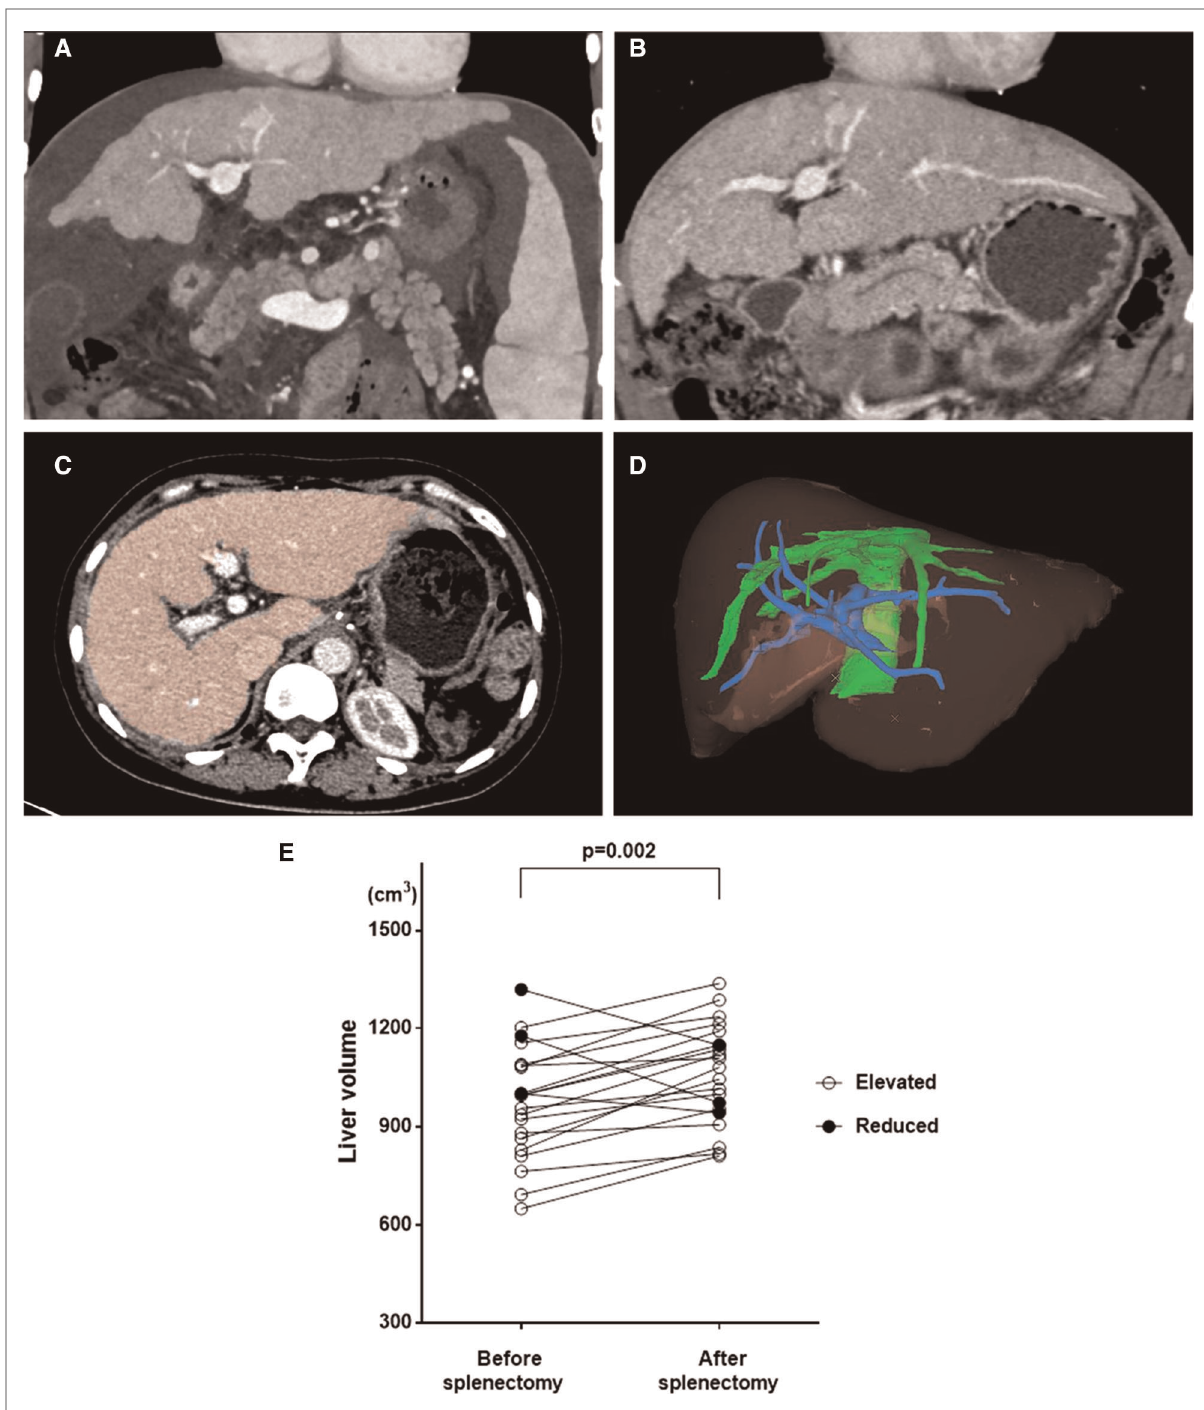
FIGURE 4 Liver regeneration were observed in many patients after surgery, we applied The Myrian® XP-Liver Work Environment (Myrian, Intrasense, France) to measure the liver volume. ( A ) CT image before surgery showed liver cirrhosis and reduced liver volume; ( B ) CT image after surgery on same layer exhibited increased liver volume which indicated liver regeneration after surgery; ( C ) The liver was stained in color to measure liver volume; ( D ) A 3-D image of liver was built to calculate the accurate liver volume; ( E ) The signi fi cant increasing of Liver volume were observed in 19 of 21 patients with integrity CT data of before and 3 months after